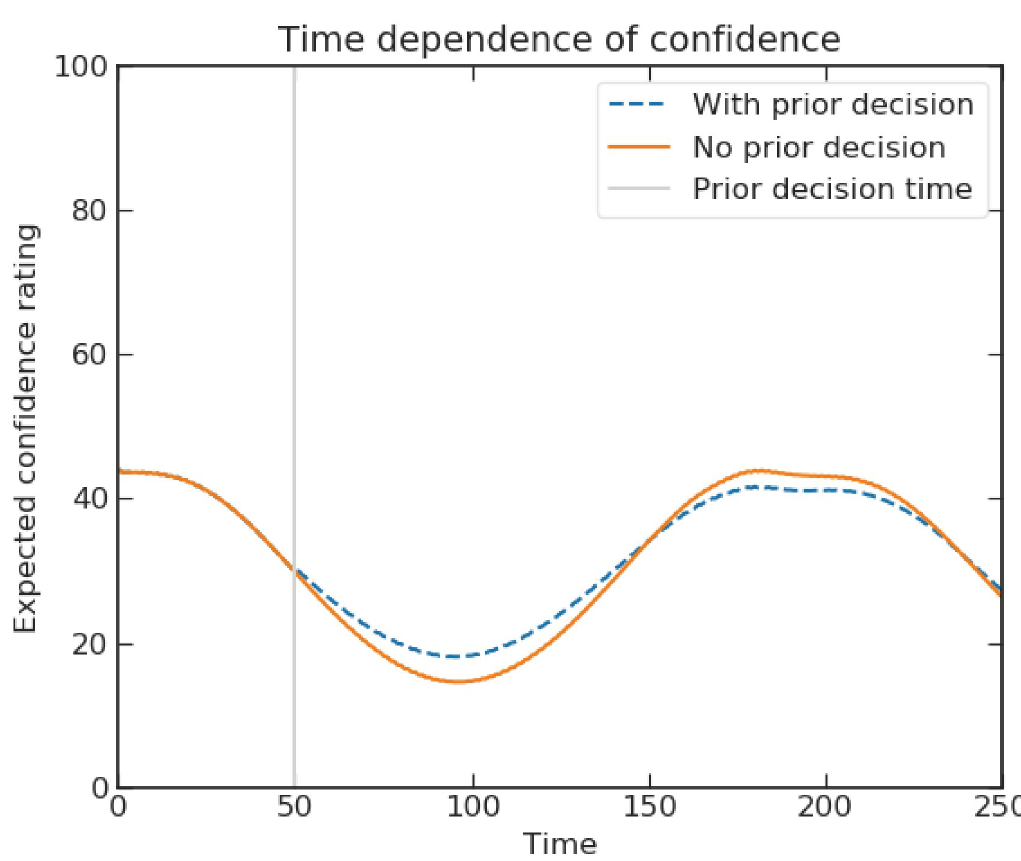
Fig 10. Expected confidence rating vs time. The orange curve shows the evolution of the expected position of the particle without a prior decision, the blue curve indicates the counterpart with a prior decision. The prior decision time is at t = 50. In the parts of the graphs where the expected position of the walk with prior decision is above that of the walk with no priori decision, there is a bolstering effect (confidence rating is amplified) and vice-versa.